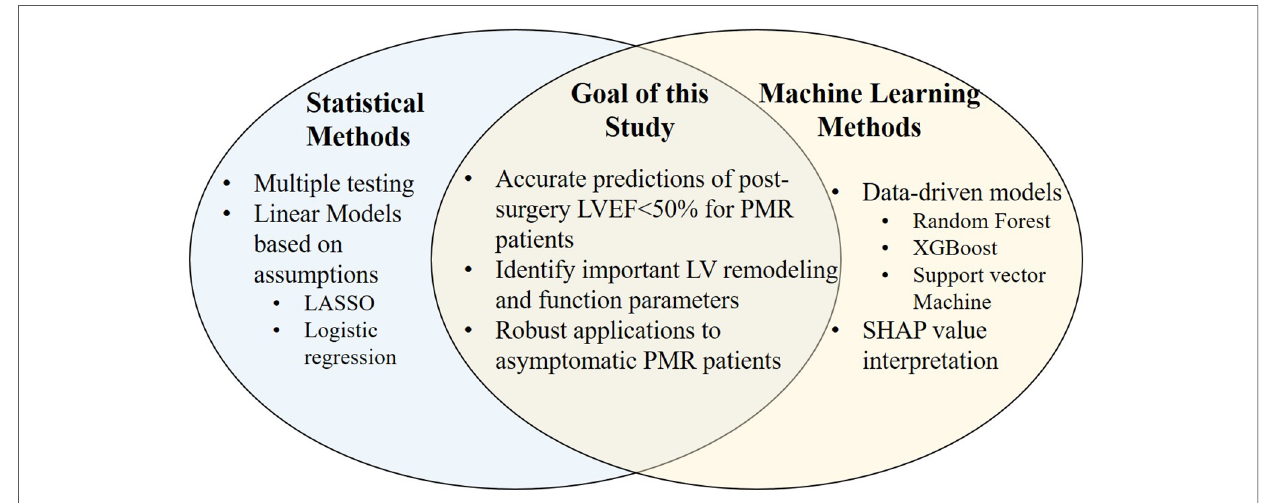
FIGURE 1 Application of regression and machine learning methods to achieve optimal analytical